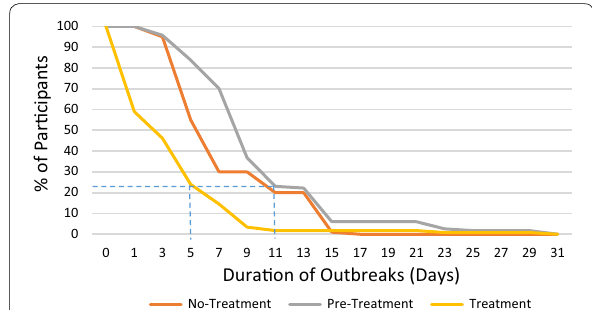
Fig. 1 Graph showing the percentage of participants versus dura- tion of outbreaks in the treatment, pre-treatment and no-treatment